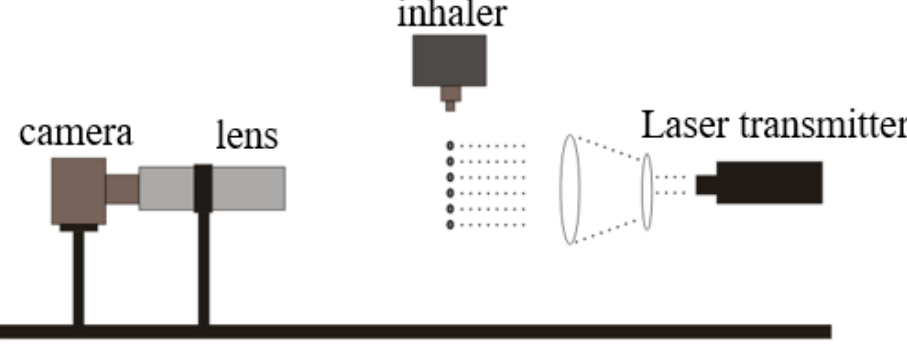
Figure 2. High-speed laser camera experimental platform.